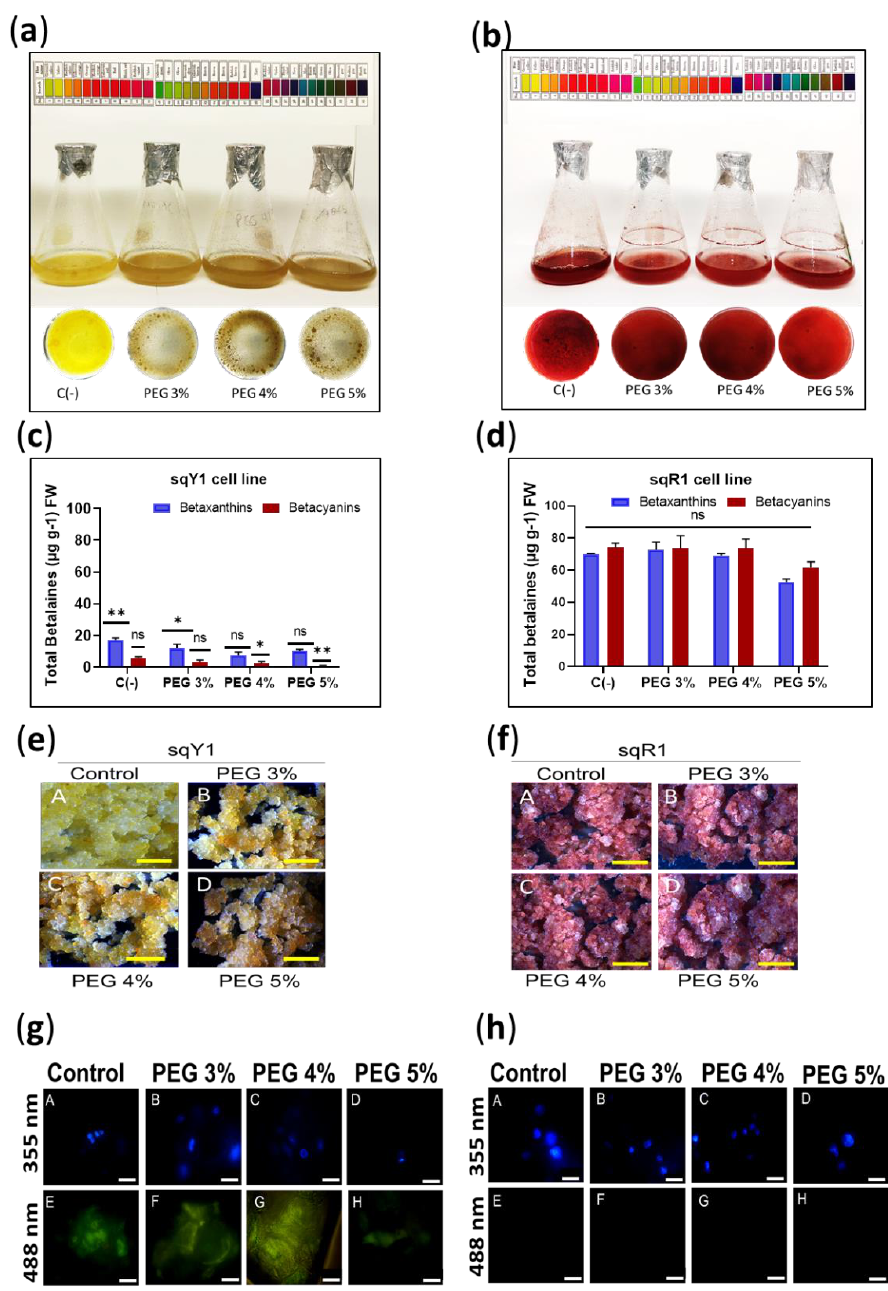
Figure 5. Induction of osmotic stress in sqY1 and sqR1 lines. ( a ) Effect of osmotic stress induced by the addition of PEG 6000 on sqY1 and ( b ) sqR1 cell lines. ( c ) Quantification of total betalains in sqY1 and ( d ) sqR1 lines. All experiments were obtained at a significance level whit three independents replicates. Bars indicate standard error. (*) Indicate statistical significance at p < 0.05, (**) Indicate statistical significance at p < 0.01. (ns) Indicate no statistical significance.Bars. ( e ) Variation of cell aggregate formation at different doses of PEG 6000 in the sqY1 line and ( f ) in the sqR1 line. Bar scale 1cm. ( g : A–D) Epifluorescence microscopy, nuclei stained with DAPI and viewed at 355 nm in the sqY1 line ( g : E–H) autofluorescence signal at 488 nm in the sqY1 line. ( h : A–D) Visualization of nuclei at 355 nm stained with DAPI in the sqR1 cell line. ( h : E–H) No autofluorescence signal was detected at 488 nm in the sqR1 cell line. Bar scale 10 µ